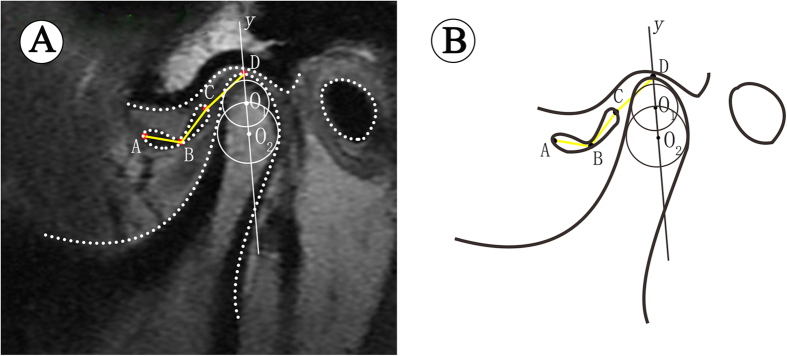
Measurement of disc length and displacement distance on MRI.(A) In TMJ MRI image, (B) Schematic diagram.